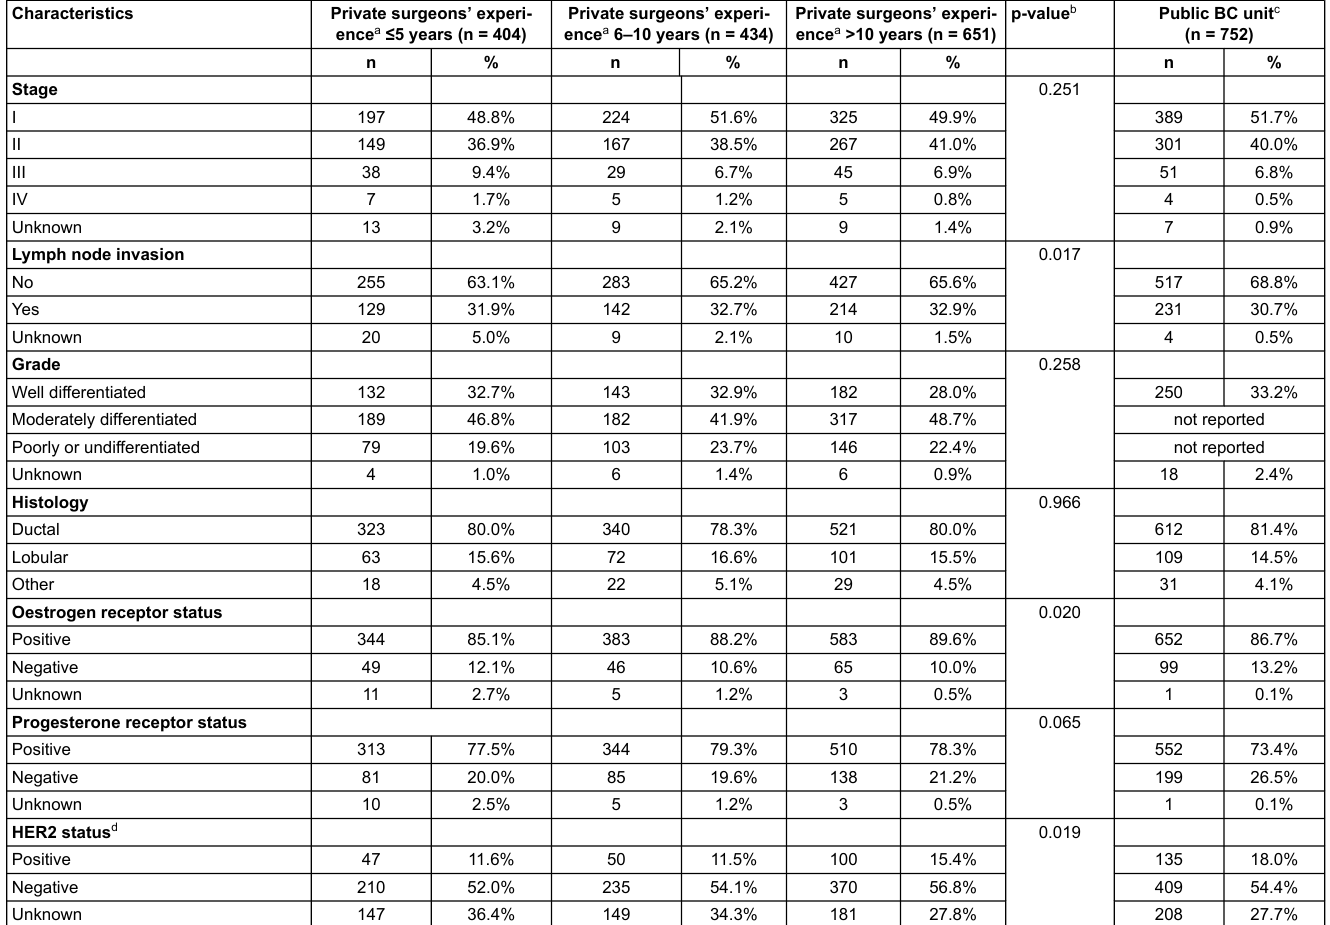
Table 2: Characteristics of the tumours according to the surgeon's experience (Geneva Cancer Registry 2000–2009).